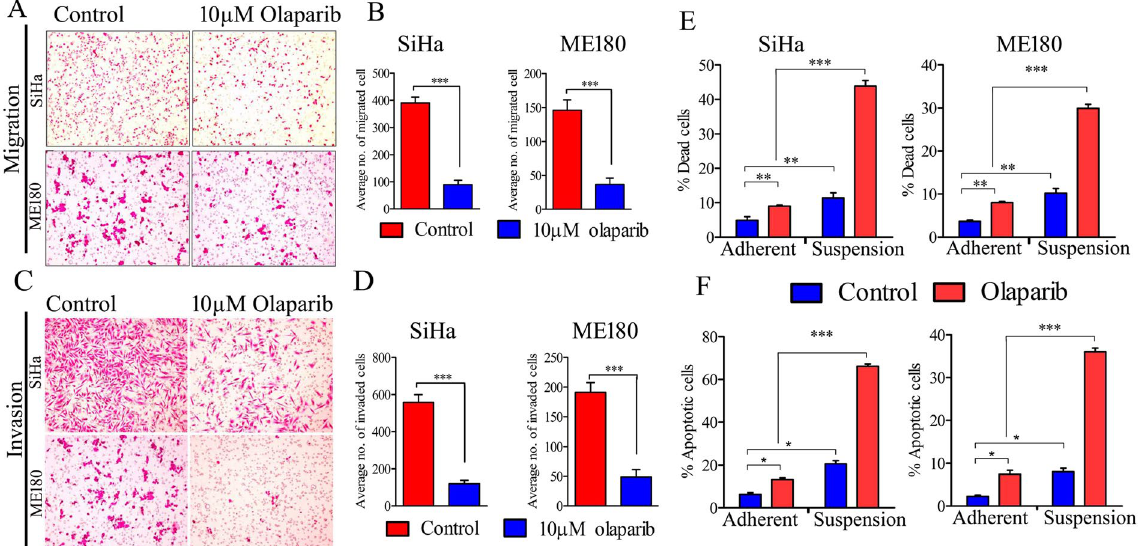
Figure 10. PARP inhibitor suppresses metastatic events in CC. ( A ) Overnight serum starved SiHa and ME180 cell lines were seeded in transwell insert (8 µ m pore size) with or without olaparib for 16 hrs. Representative images show migrated cells stained with crystal violet. ( B ) Bar graph showing quantitative cell migration in untreated and olaparib treated CC cell lines. ( C ) Overnight serum starved SiHa and ME180 cell lines were seeded in transwell insert (8 µ m pore size) coated with matrigel matrix and 10 µ M olaparib was added with the cells for 48 hrs. Representative image shows invaded cells stained with crystal violet. ( D ) Bar graph showing quantitative cell invasion through matrigel matrix in untreated and olaparib treated CC cell lines. ( E ) SiHa and ME180 cell were cultured in adherent and suspension condition. Olaparib treatment was done for 24 hrs and cells were stained with PI. Bar graph showing the quantitative distribution of dead cells. ( F ) Olaparib treated adherent and suspension CC cell lines were co-stained with Annexin V and PI. Bar graph displaying quantitative distribution of apoptotic